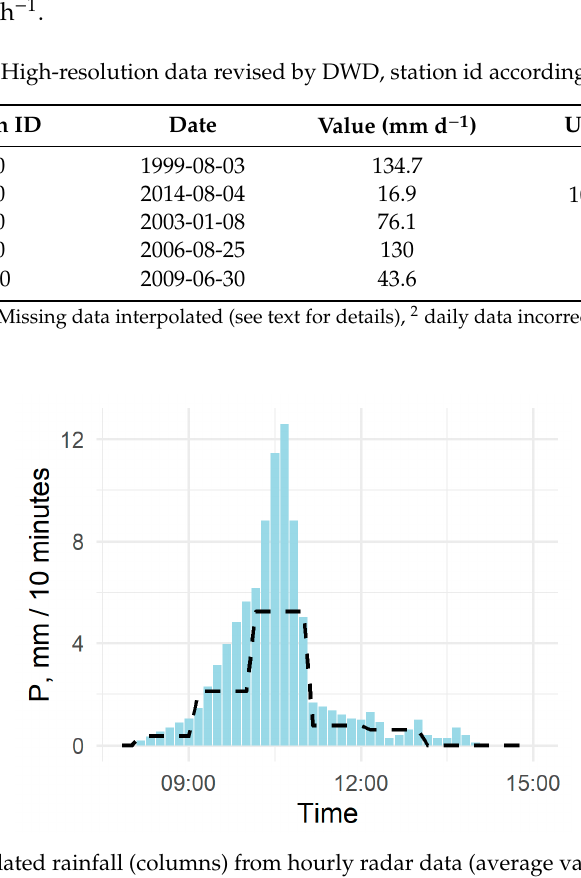
Figure A1. Interpolated rainfall (columns) from hourly radar data (average values as broken line).